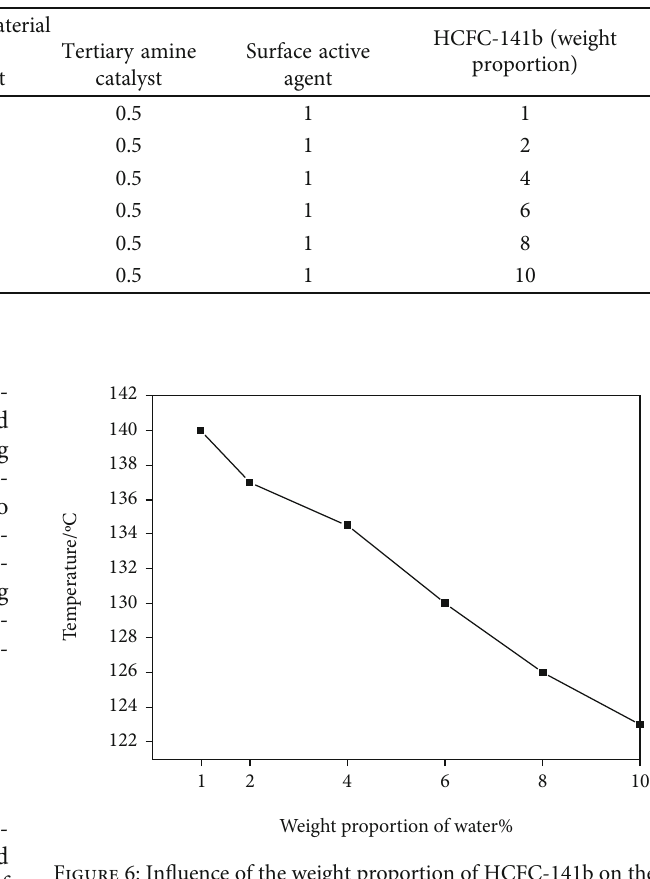
Table 2: Experiment weight proportion scheme of HCFC-141b